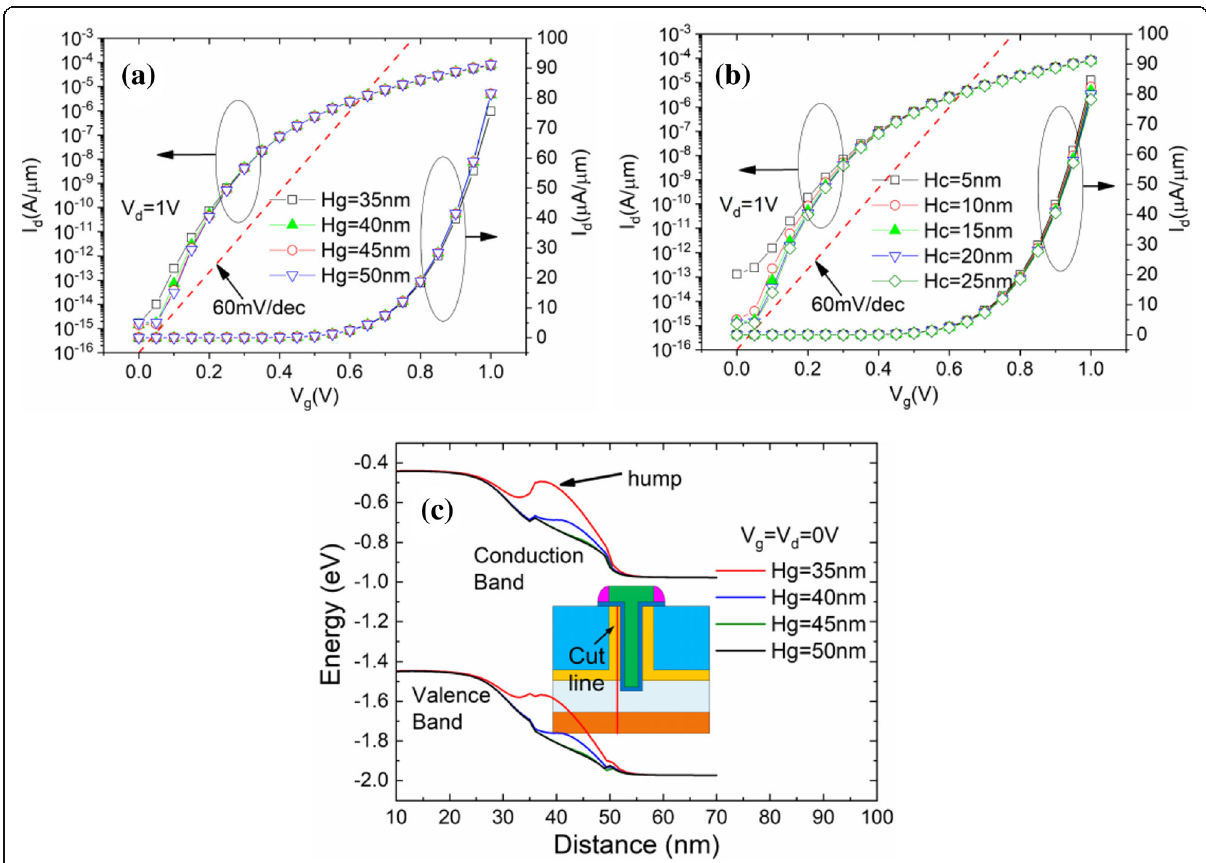
Fig. 7 Simulated transfer characteristics of TGTFET with a different Hg, b different Hc, and c the conduction band hump on the current path